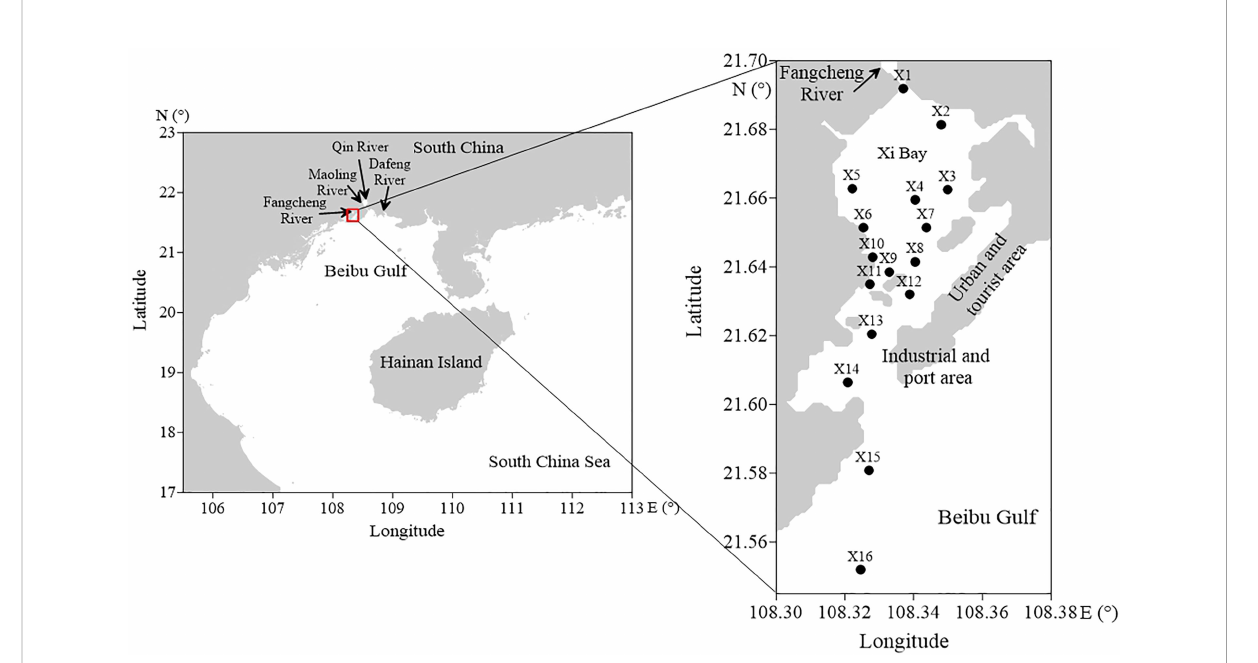
FIGURE 1 Study area and the sampling stations in Xi Bay, Beibu